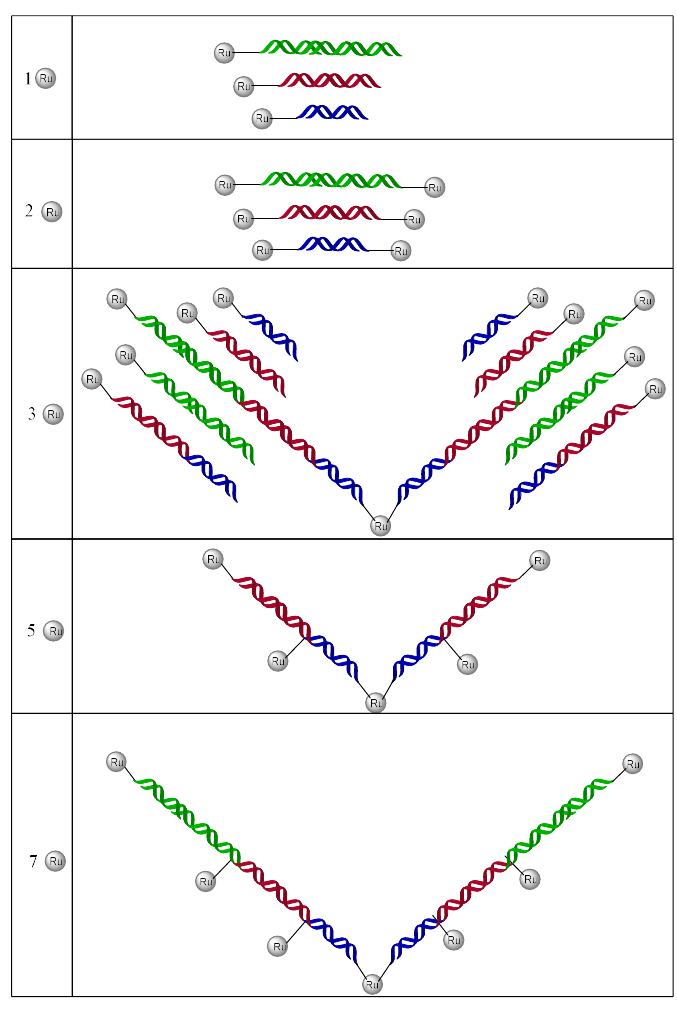
Figure 11. Structures of the linear DNA nanoassemblies with one to seven ruthenium complexes [104].